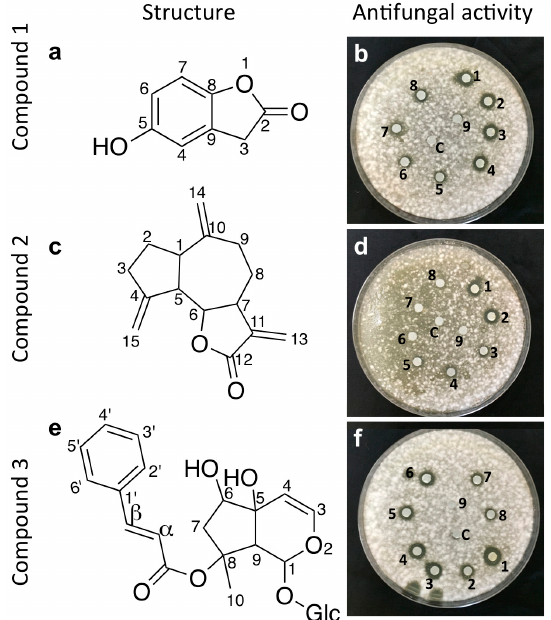
Figure 4. Structures and in vitro activity of the purified anti- Fusarium compounds from fungal endophyte strains WF5, WF6 and WF7. ( a ) Structure of compound 1,5-hydroxy benzofuranone (from strain WF5); ( b ) Representative picture of the disc diffusion assay showing the anti- Fusarium activity of compound 1 ; ( c ) Structure of compound 2 , dehydrocostus lactone (from strain WF6); ( d ) Representative picture of the disc diffusion assay showing the anti- Fusarium activity of compound 2 ; ( e ) Structure of compound 3 , harpagoside (from strain WF7); ( f ) Representative picture of the disc diffusion assay showing the anti- Fusarium activity of compound 3 . Numbers (1–9) denote a concentration gradient of 4000, 2000, 1000, 500, 250, 125, 62.5, 31.25, 15.62 and 7.8 µg/mL while C denotes the solvent control.